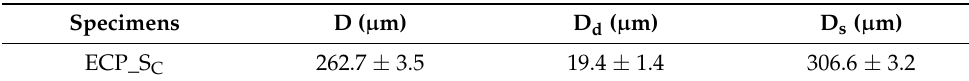
Figure 1. Surface profiles of the ECP textured specimens (ECP_S C ): ( a ) 3D surface image; ( b ) 2D image; ( c ) Surface profile of one dimple. Table 2. Dimensions of textured specimens with circular patterns.